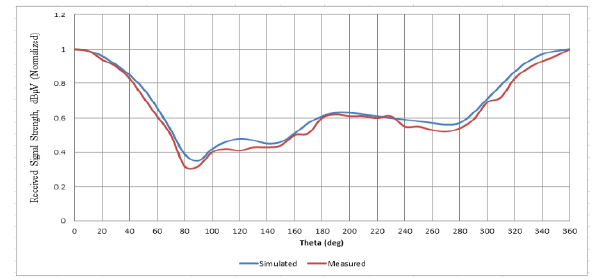
Figure 5. Simulated and measured radiation pattern at 2.45